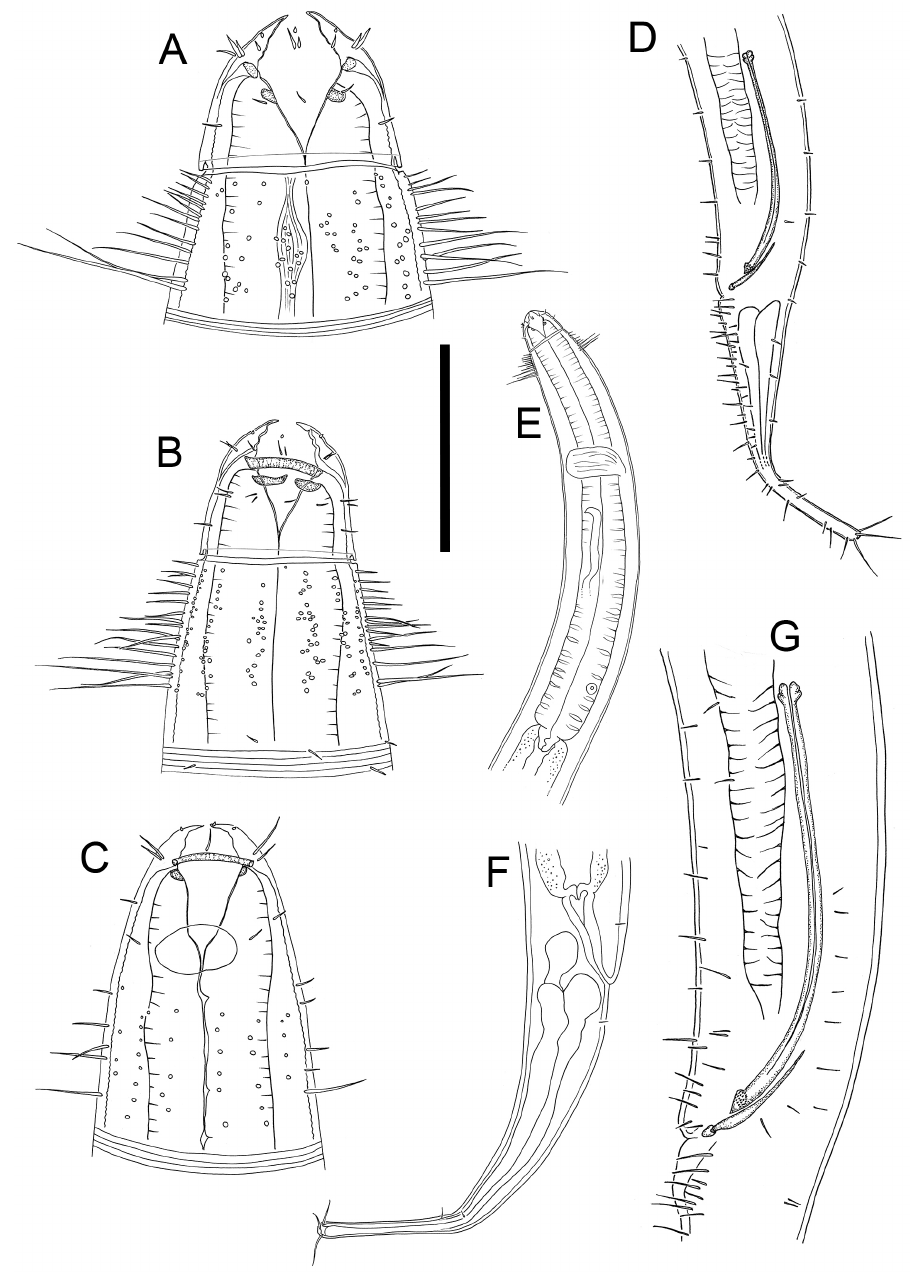
Fig. 10. Deraionema barbatum gen. et sp. nov. A , D , G . Paratype (NIWA154915). B , E . Holotype (NIWA 154914). C , F . Paratype (NIWA154917). A – B . Lateral view of male cephalic region. C . Female cephalic region. D . Male posterior body region. E . Male anterior body region. F . Female posterior body region. G . Copulatory apparatus. Scale bar: A = 50 µm; B = 65 µm; C = 55 µm; D = 140 µm; E = 240 µm; F = 120 µm; G = 70